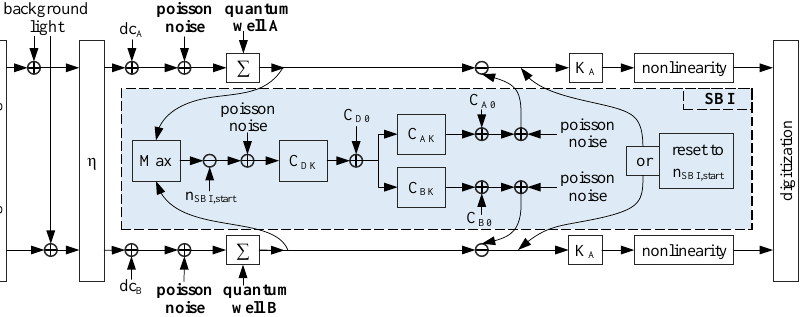
Figure 8. The SBI model. K A and K B represent the charge-to-voltage coefficient. C DK and C D 0 represent the charge difference coefficient and offset, respectively. (or C BK ) and C A 0 (or C B 0 ) represent the compensation charge coefficient and offset, respectively.